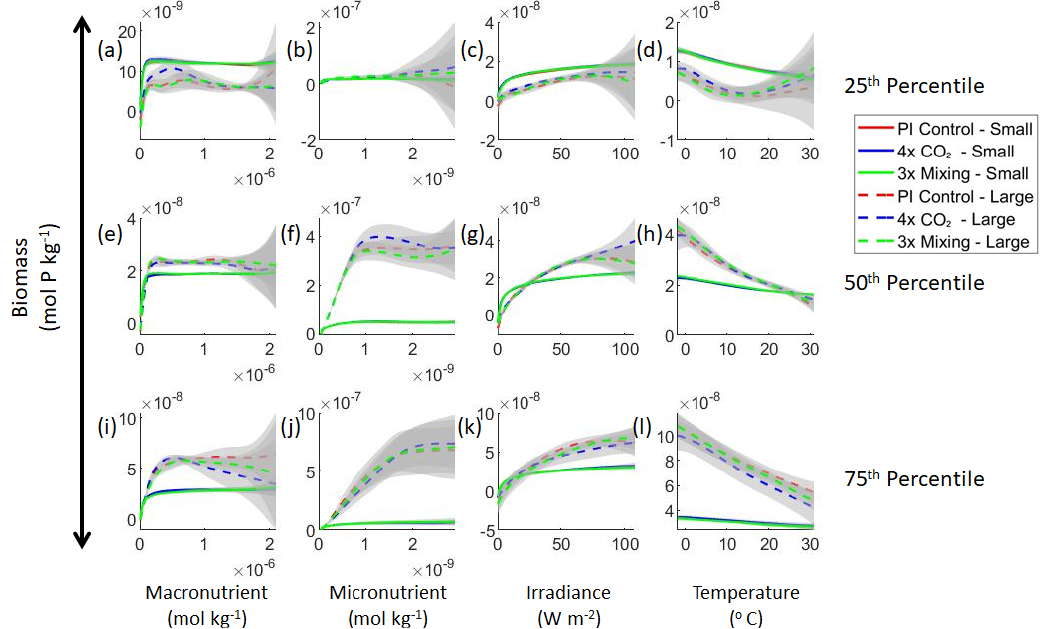
Figure 3. Sensitivity analysis plots for the small and large phytoplankton of Case 1. Each line is the prediction for the NNE (i.e., the average prediction of 25 NNs) specific to each model run, and the color of each line represents the model run (PI Control – red; 4 × CO 2 – blue; 3 × Mixing – green). The solid lines correspond to the NNE predictions for small phytoplankton and the dashed lines to the NNE predictions for large phytoplankton. The gray region around each line shows 1 standard deviation in the predictions of the individual NNs that make up each NNE (e.g., the gray region around the solid red curves shows the standard deviation in the predictions of the 25 NNs that make up that particular NNE). The rows correspond to the percentile value at which the other predictor variables are held constant (e.g., panel a varies the macronutrient across its min–max range and holds the micronutrient, irradiance, and temperature at their respective 25th percentile values). Columns show the x -axis variables as they vary between their min–max range. The y axis in all panels is the biomass concentration. Note that the biomass scale changes with each panel.